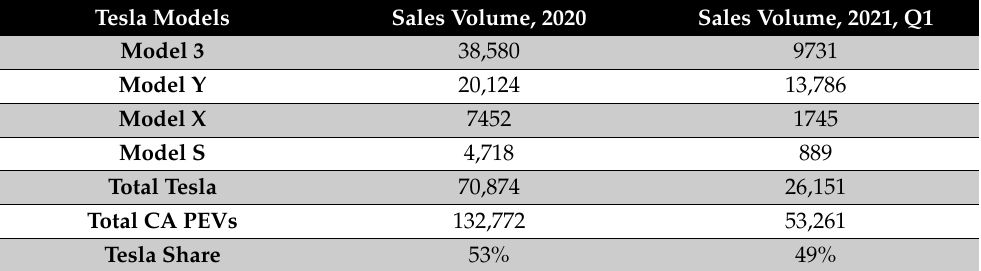
Table 4. Tesla’s Share of the California Market for PEVs, 2020–2021